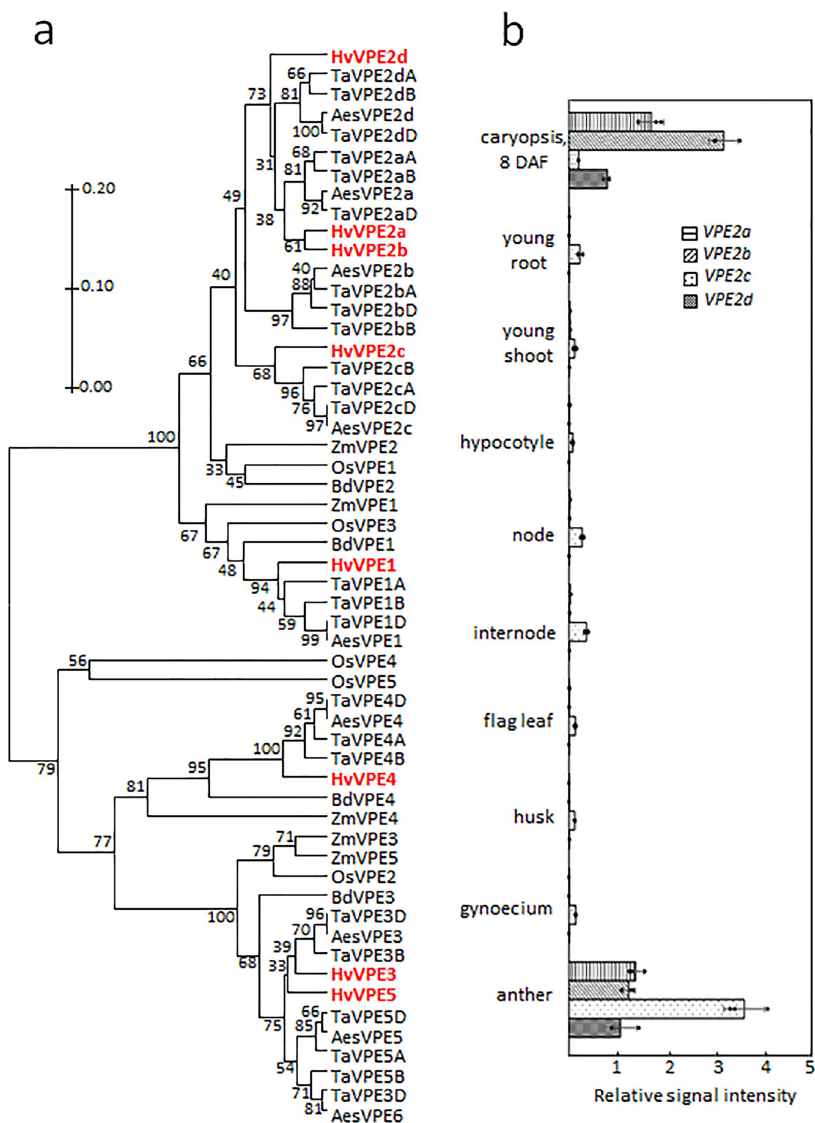
Fig. 2 The VPE2 gene subfamily expansion in the Triticeae and its expression in the barley plant. a A bootstrap consensus tree of the VPE protein sequences from Hordeum vulgare (Hv), Aegilops speltoides (Aes), Triticum aestivum (Ta) (all belong to Triticeae tribe), Zea mays (Zm) (Andropogoneae), Oryza sativa (Os) (Oryzeae), and Brachypodium distachyon (Bd) (Brachypodieae). The maximum-likelihood tree was supported by 1000 bootstrap replicates. The scale bar represents evolutionary distances, as quanti fi ed by the number of substitutions per amino-acid residue. The barley VPEs are shown in red. Gene IDs are given in Supplementary Table 4. b Transcript abundances of VPE2a , VPE2b , VPE2c , and VPE2d in various parts of the barley plant, assessed using qRT-PCR. Data given as the mean ± SD ( n = 3). Abbreviation: DAF days after fl